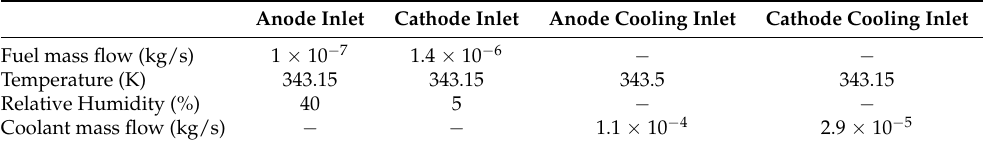
Table 4. Summary of the operating